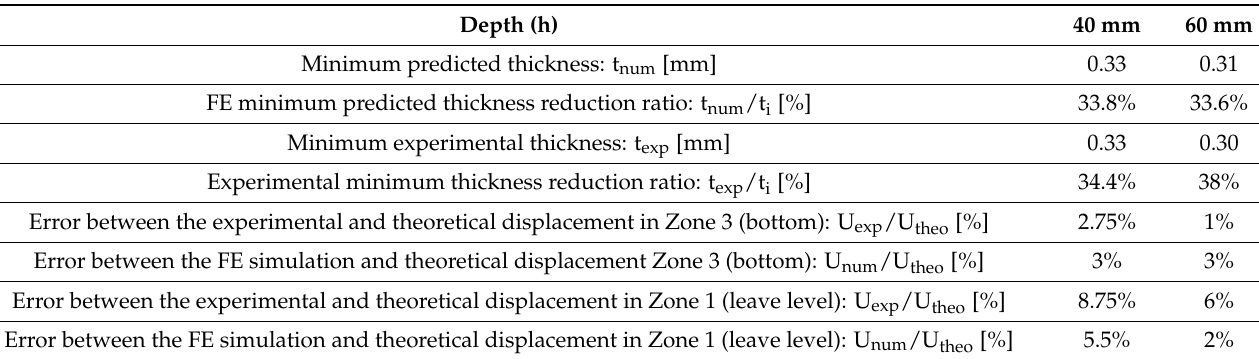
Figure 17. Relative error, U exp /U theo and U num /U theo , for the case of (h = 60 mm, α = 50°).